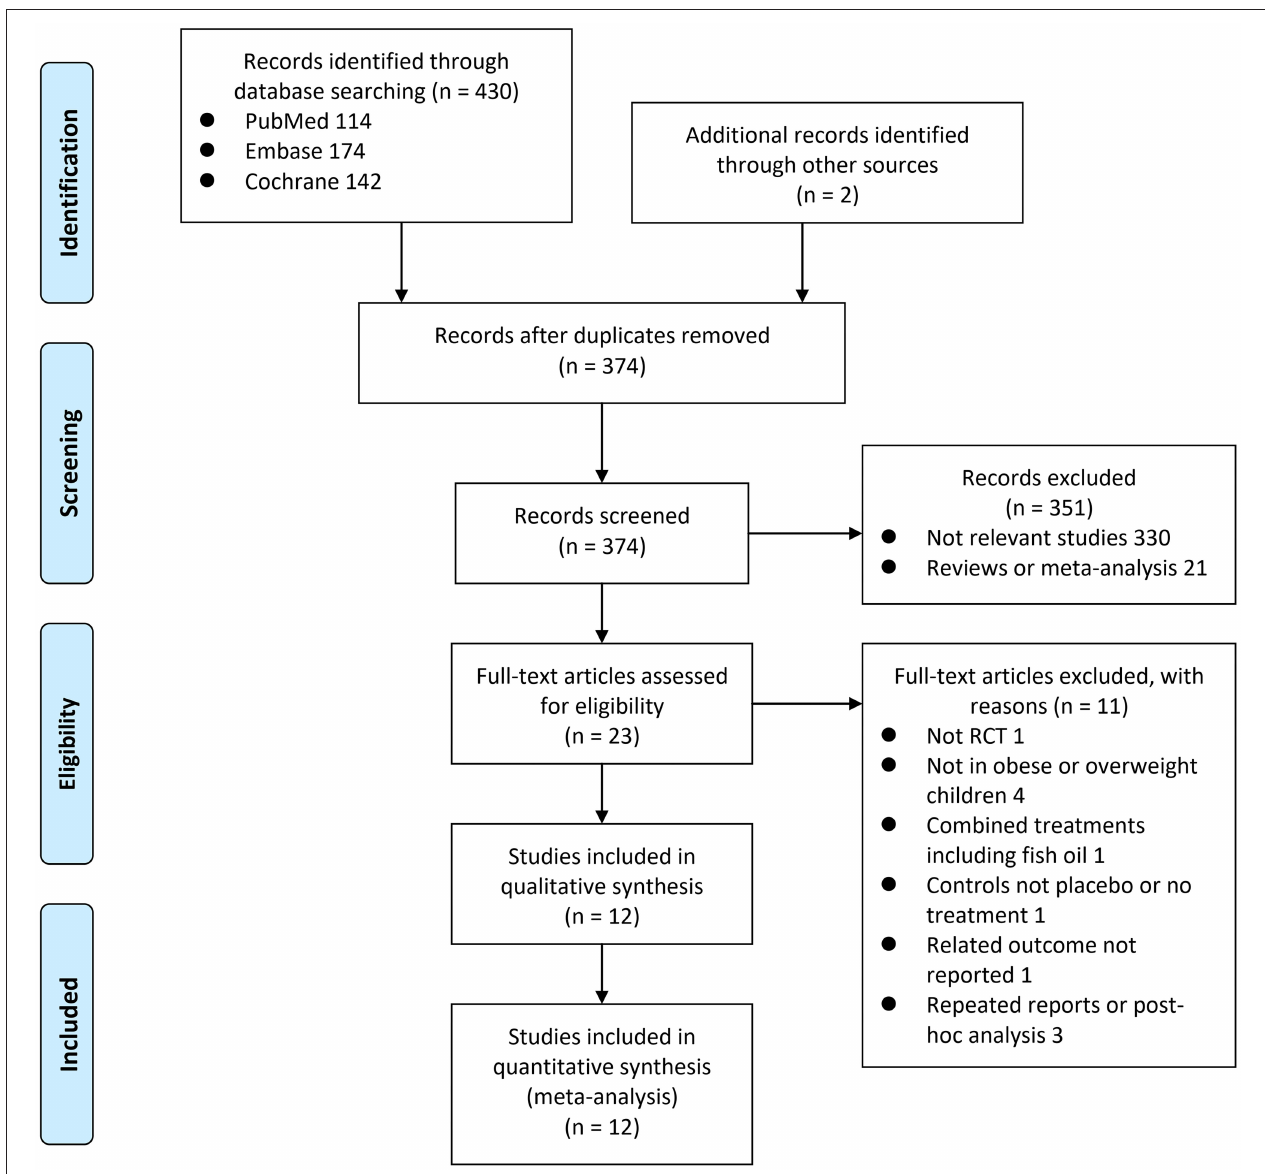
FIGURE 1 | Flowchart of literature